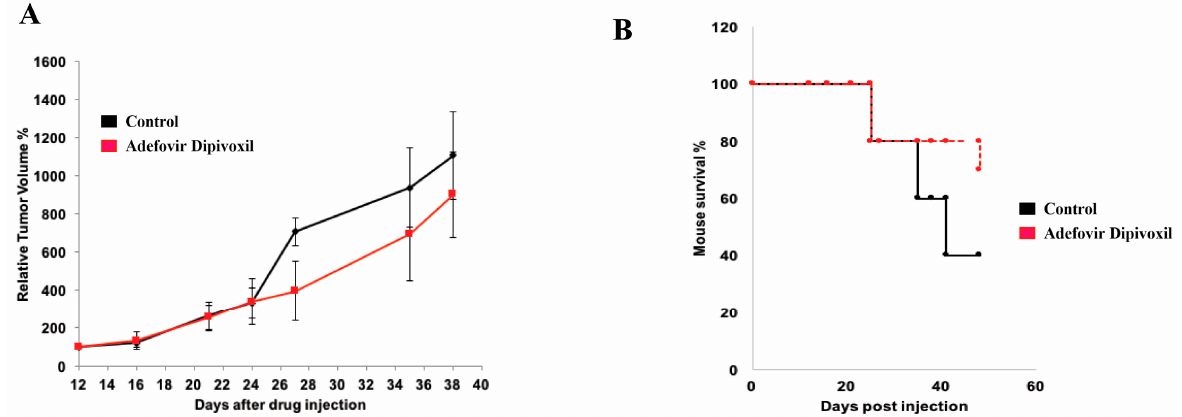
Figure 12. In vivo effect of adefovir dipivoxil. ( A ) Effect of Adefovir dipivoxil on the MTC tumor growth in vivo. ( B ) Effect of Adefovir dipivoxil on the overall survival of MTC tumor bearing mice.